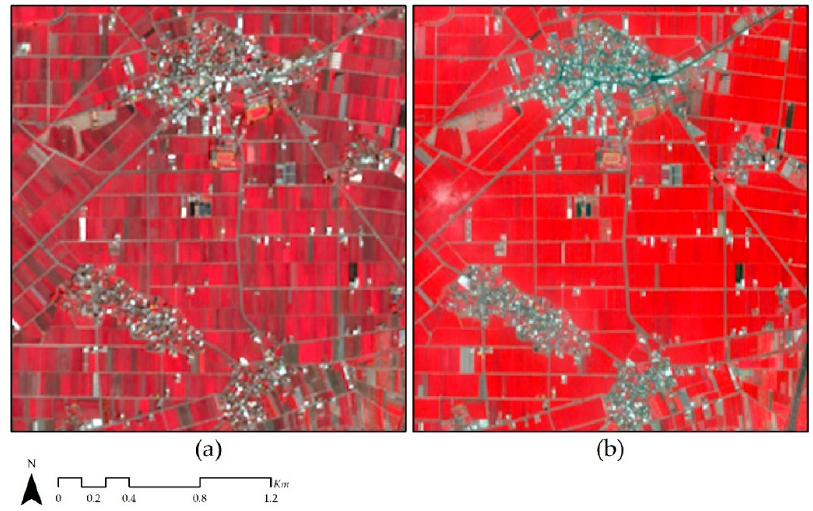
Figure 5 . The first cultivation of Dapi in 2016 ( a ) and 2017 ( b ) with G, R, and NIR bands. The red areas on the images are all rice fields, but in 2016, they are a different color shade, which means that the transplanting time is not consistent, which influences the accuracy of the yield estimation.